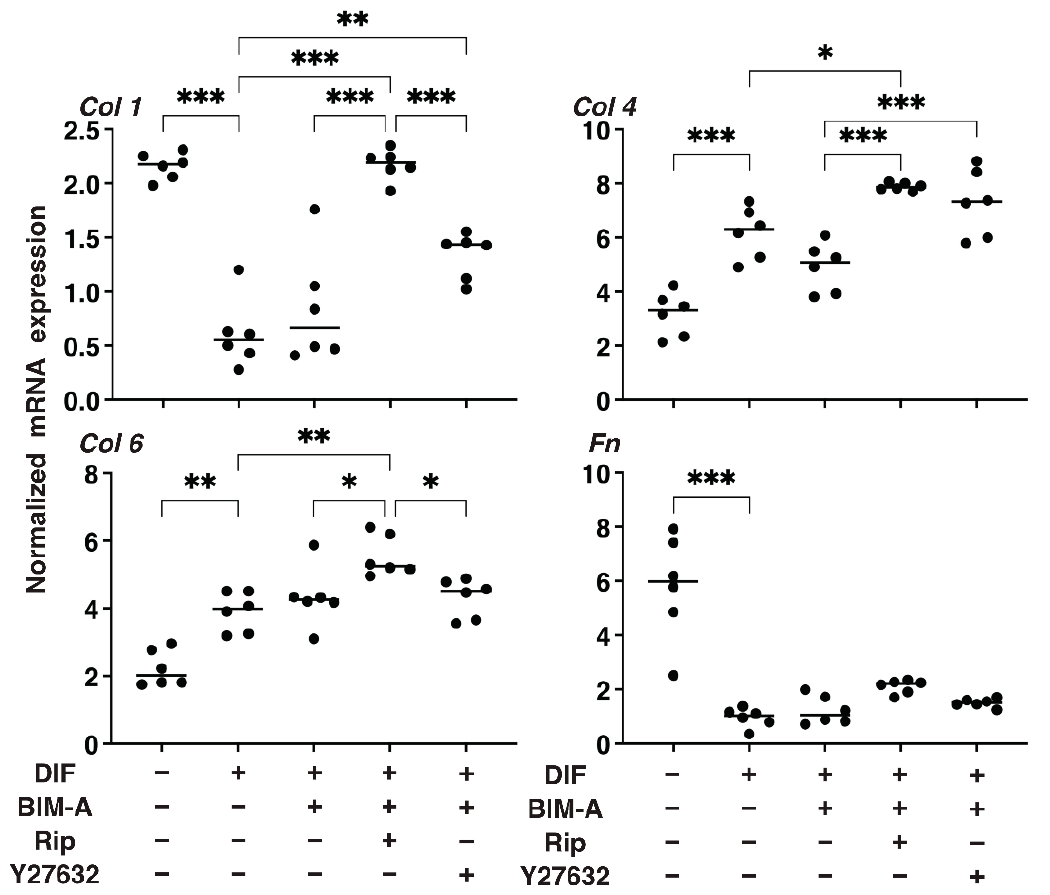
Figure 8. Additional effects of ROCK-i on BIM-A on the ECM-related mRNA expression of 3T3-L1 3D spheroids. The 3D spheroids of 3T3-L1 cells were cultured under several conditions: preadipocytes of 3T3-L1 cells or their adipogenic differentiation (DIF) in the presence or absence of the combination of 100 nM BIM-A (BIM-A) and ROCK-i (10 μ M Ripasudil (Rip) or 10 μ M Y27632). The specimens collected on Day 7 were subjected to a qPCR analysis to estimate the mRNA expression of ECMs ( Col : collagen, Fn : fibronectin). All experiments were performed in duplicate using fresh preparations, each of which consisted of 16 spheroids. Data are presented as the arithmetic means ± the standard error of the mean (SEM). * p < 0.05, ** p < 0.01, *** p < 0.005 (ANOVA followed by a Tukey’s multiple comparison test).